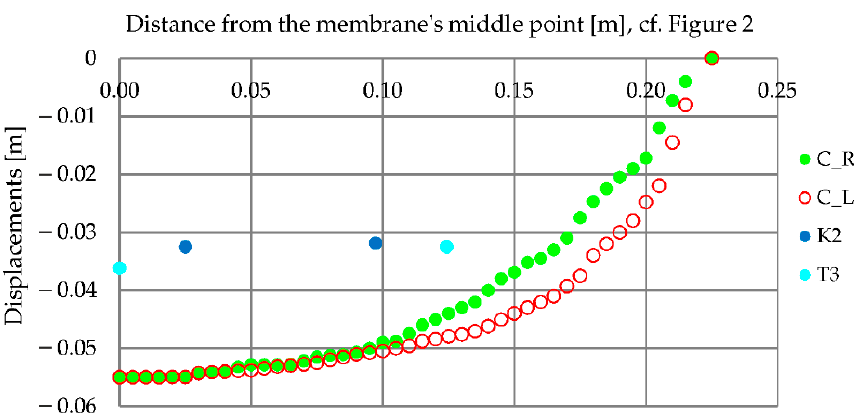
Figure 5. Approximation of the C_L ( a ) and C_R ( b ) test results using a 7th degree polynomial.